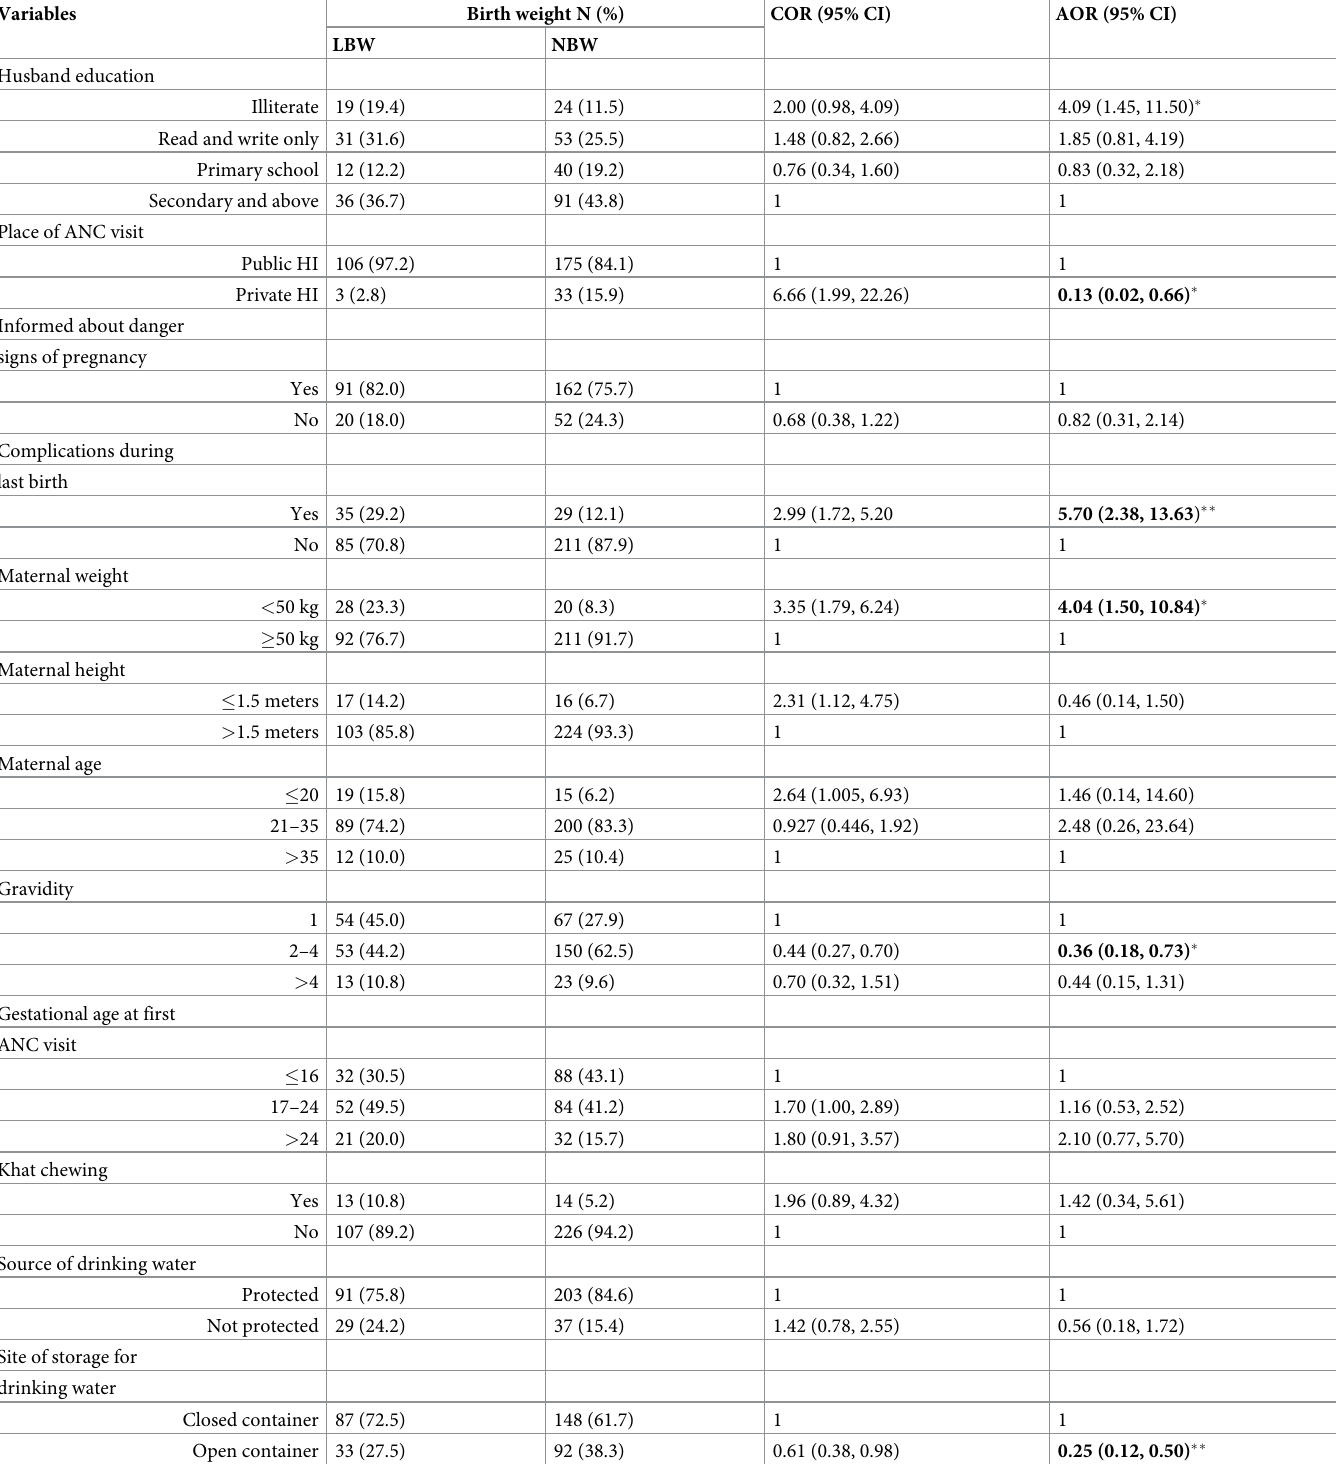
Table 4. Association of socio-demographic, obstetric and environmental risk factors with low birth weight in North Wello Zone Hospitals, Ethiopia, December